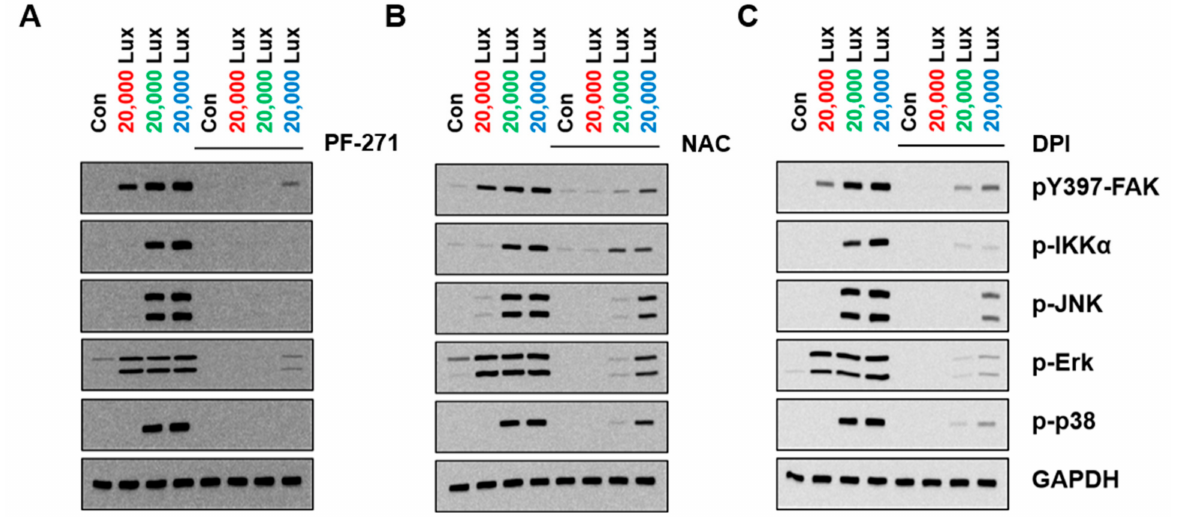
Figure 4. FAK inhibition or ROS scavengers reduced LED light-induced MAPKs activation. HaCaT cells in a 6-well plate were pretreated with FAK inhibitor ( A ) NAC (10 mM) ( B ) or DPI (10 µ M) ( C ) for 1 h and then were exposed to LED lights for 10 min. Shown are immunoblots of pY397 FAK, p-IKK α